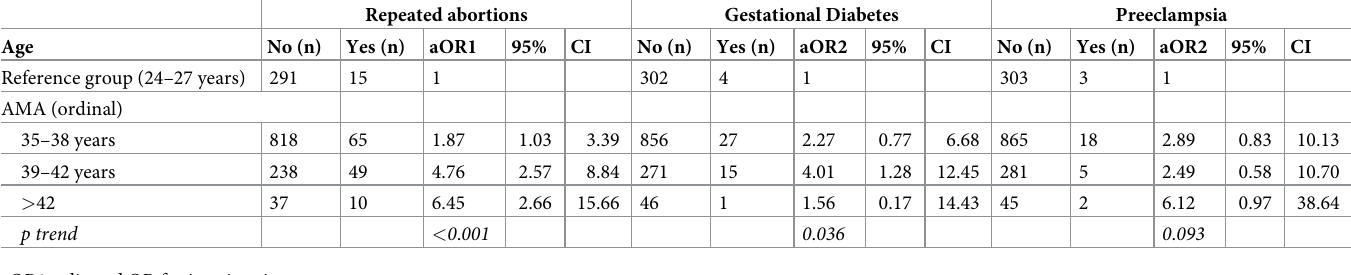
Table 4. Associations between AMA categorized in an ordinal array and repeated abortions, gestational diabetes and preeclampsia. Repeated abortions Gestational Diabetes